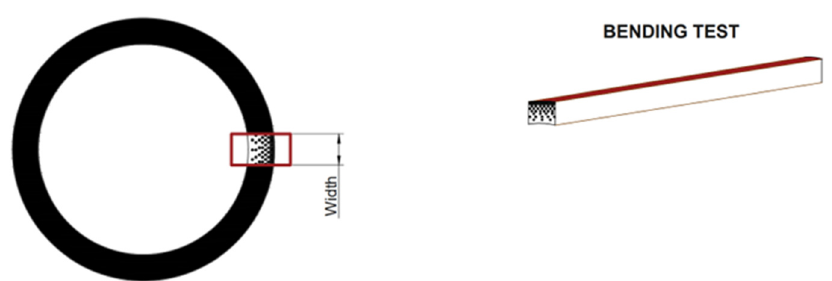
Figure 3. Specimens in the culm for the bending test and microscope observation.